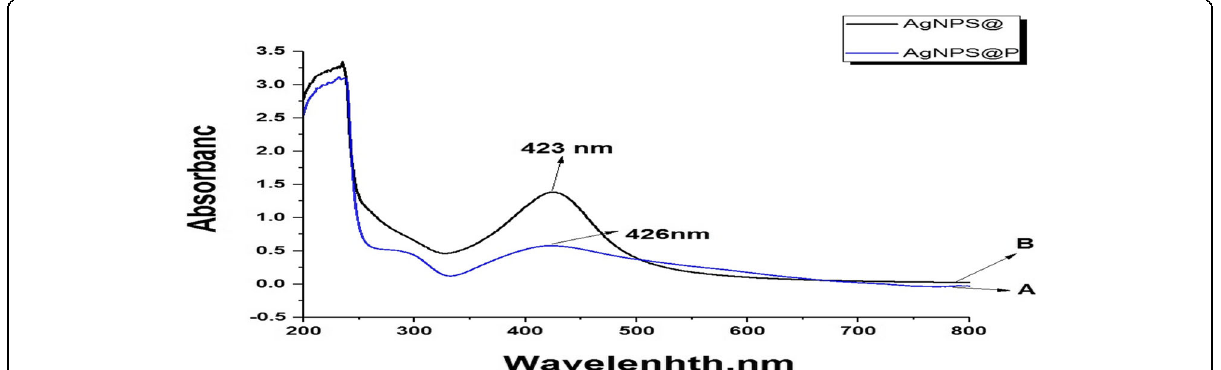
Fig. 1 The ultraviolet-visible (UV-VIS) spectrum of (A) AgNPS@P and (B) AgNPS only